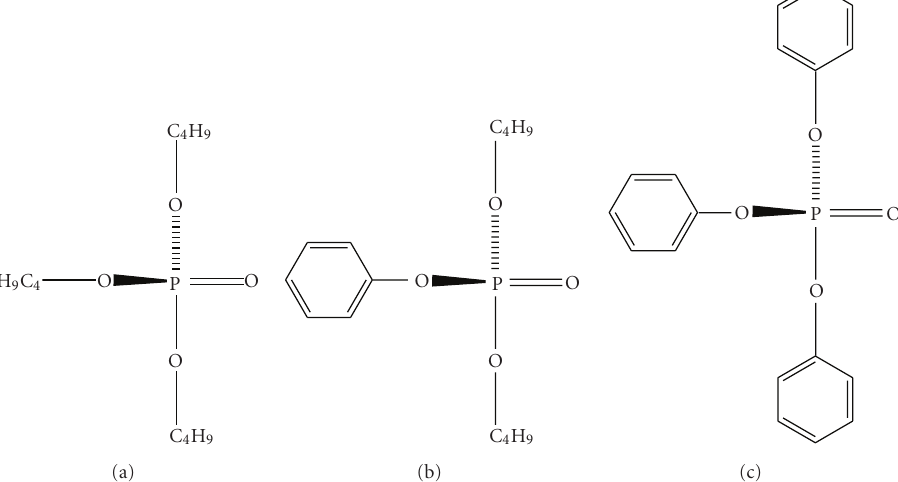
Figure 5: Chemical structure of constituents of aircraft certified hydraulic fluids. (a) Tri-butyl phosphate, (b) di-butyl phenyl phosphate, (c) tri-phenyl phosphate.